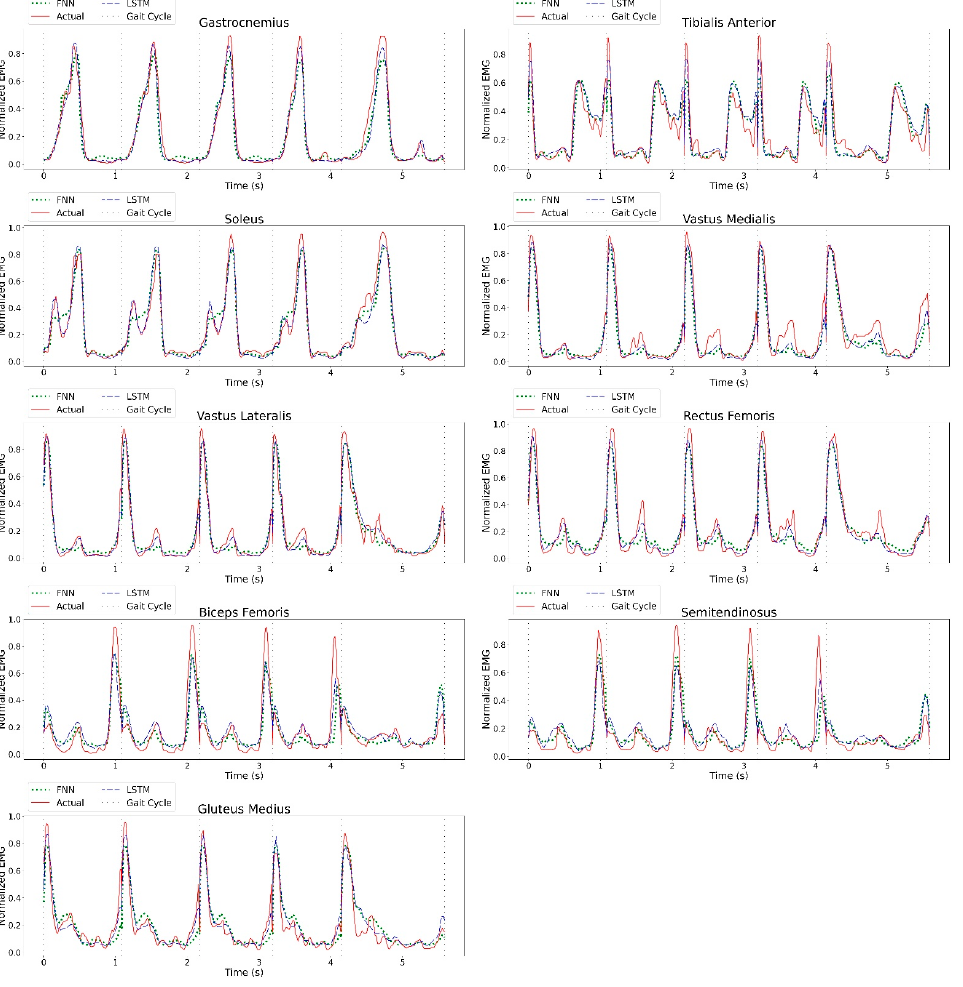
Figure A1. A plot of actual vs. predicted muscle activities of the test data (Sample A).